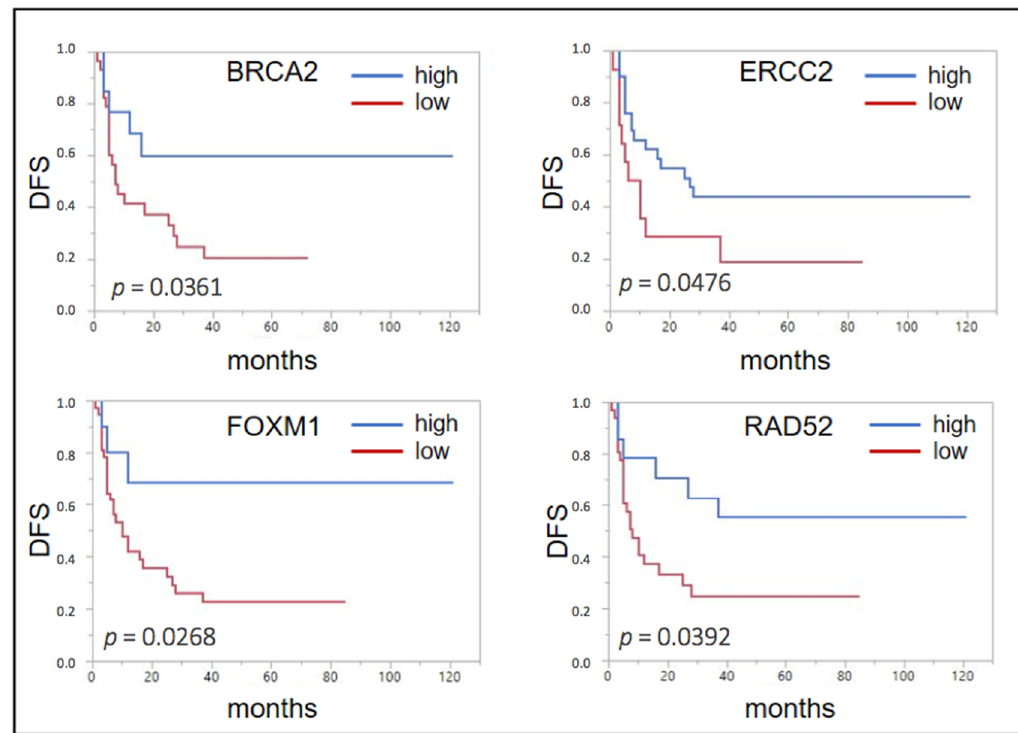
Figure 1. Forrest plots of the correlation between RNA expression and disease free survival (DFS) in the unselected Mannheim cohort.